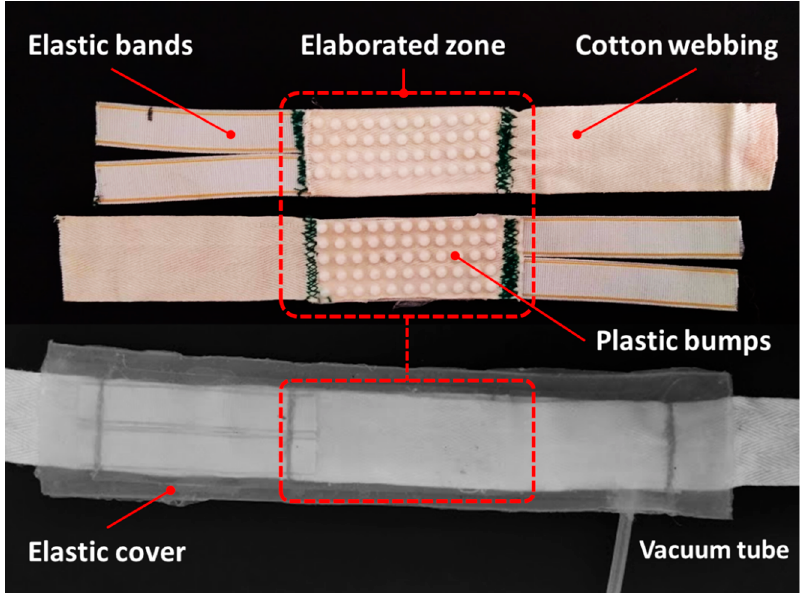
Figure 4. ( Top ) The internal layers of the TBC with elastic bands, elaborated zone with rigid bumps, and inextensible cotton webbing; ( bottom ) final assembled TBC inside the air sealed silicone rubber cover.